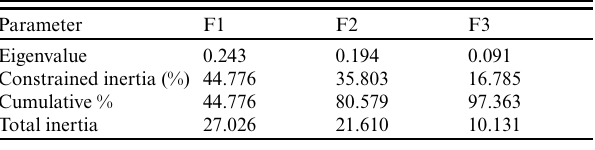
Table 6. Redundancy analysis results for the reasons for prioritizing the principles of success in Taganga.